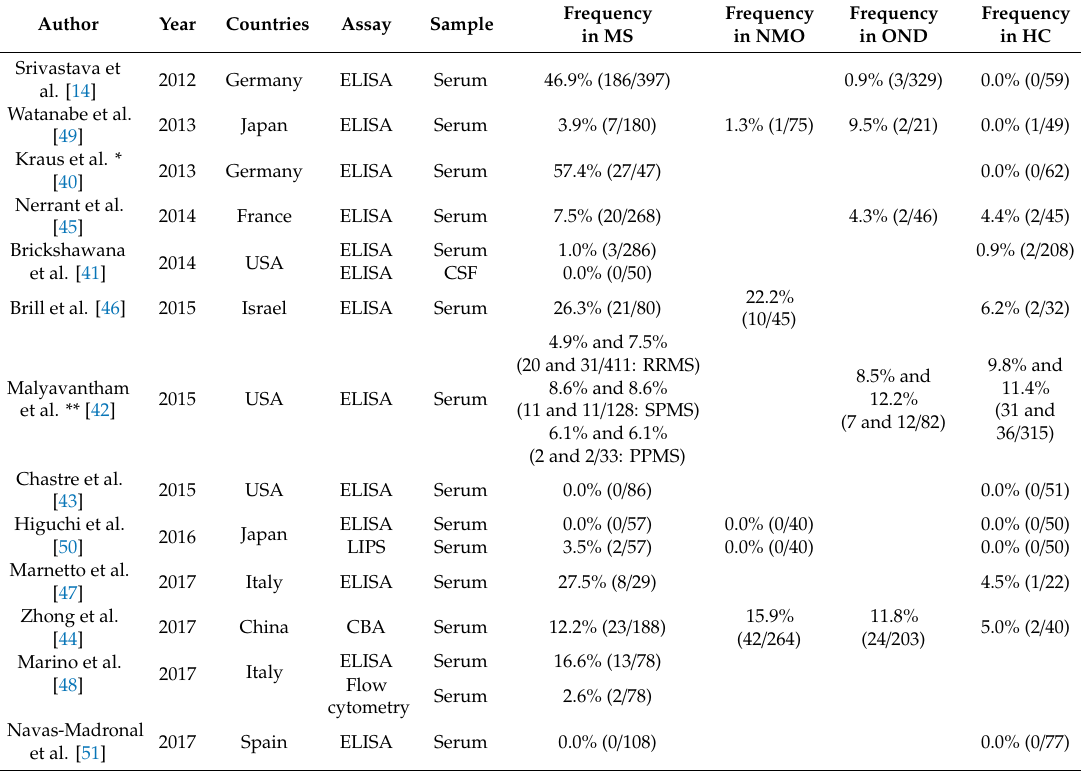
Table 2. The previous results of anti-Kir4.1 antibodies detection in MS in various